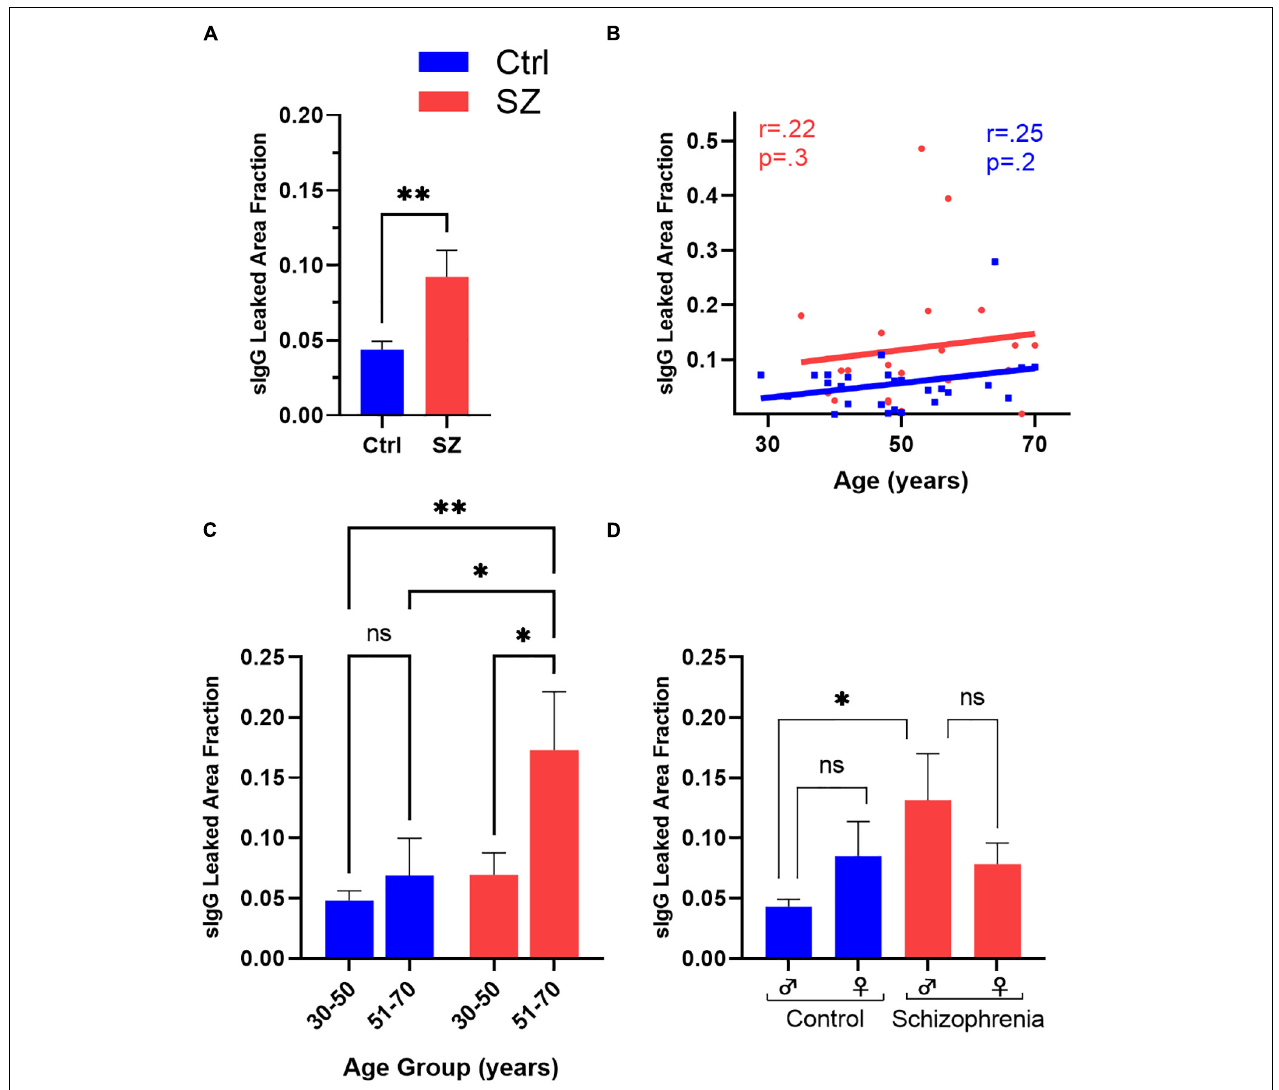
FIGURE 4 | Comparison of the extent of BBB breakdown in the hippocampus and surrounding temporal cortex of the SZ and Ctrl subjects with respect to diagnosis, age, and sex. (A) SZ subjects demonstrated a significantly higher hippocampal and temporal cortex IgG leaked area fraction than Ctrls. (B) Correlation coefficients of Ctrls and SZ between IgG leaked area fraction and age. Comparison of SZ vs. Ctrls subdivided by middle- and advanced-aged groups (C) or gender (D) to assess for exploratory inter-and intra-group BBB leakage differences. ∗ p < 0.05, ∗∗ p < 0.01, with false discovery rate ( q < 0.05) to correct for multiple comparisons where